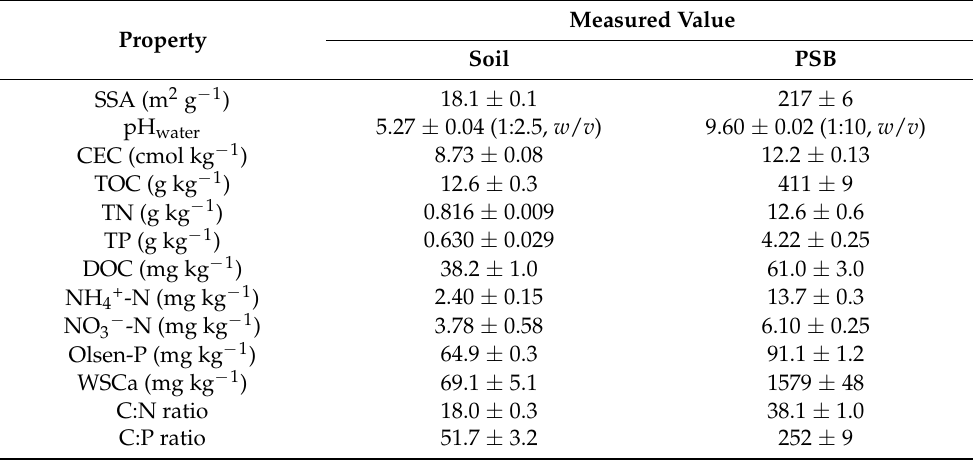
Table 1. Basic physicochemical properties (air-dried basis) of the vegetable farmland soil and palm silk biochar (PSB) used in the present